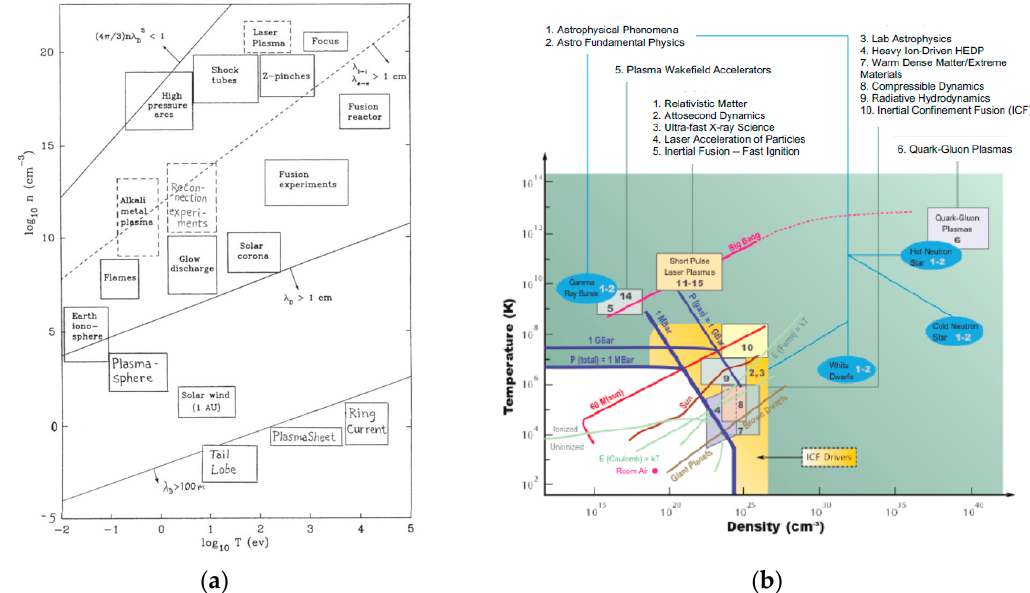
Figure 1. Typical parameters of lab and nature’s plasmas: Cartesian representation of density and temperature range associated with ( a ) heliospheric (10 2 – 10 9 K) [2] and ( b ) astrophysical (10 2 – 10 14 K) plasma [4]. Upper-right region corresponds to pushing parameters toward nuclear fusion ignition.